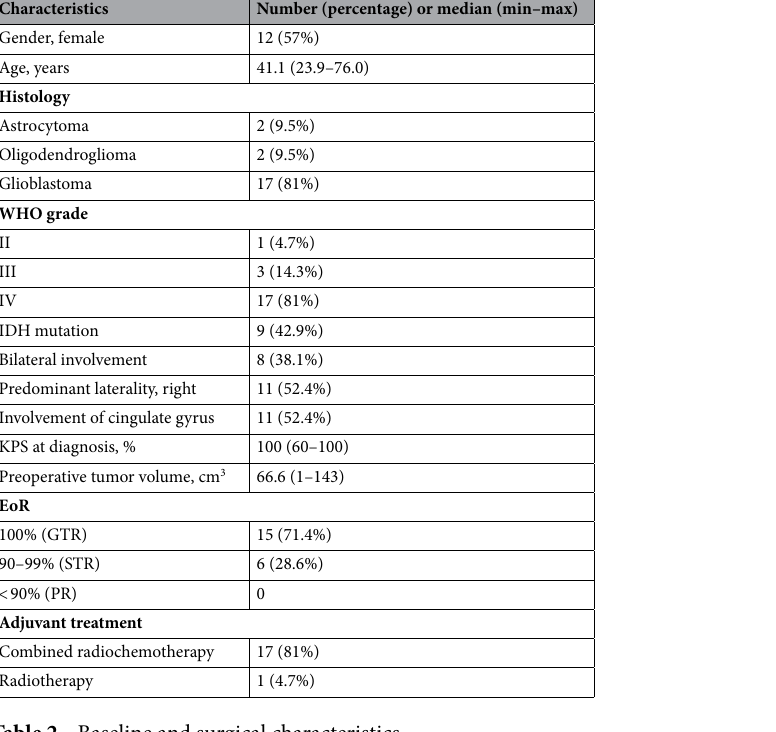
Table 2. Baseline and surgical